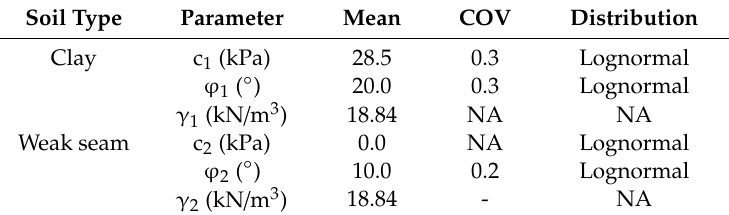
Figure 10. Slope geometry and deterministic slope stability analysis results for example II. Table 4. Statistics of soil parameters for example Ⅱ .